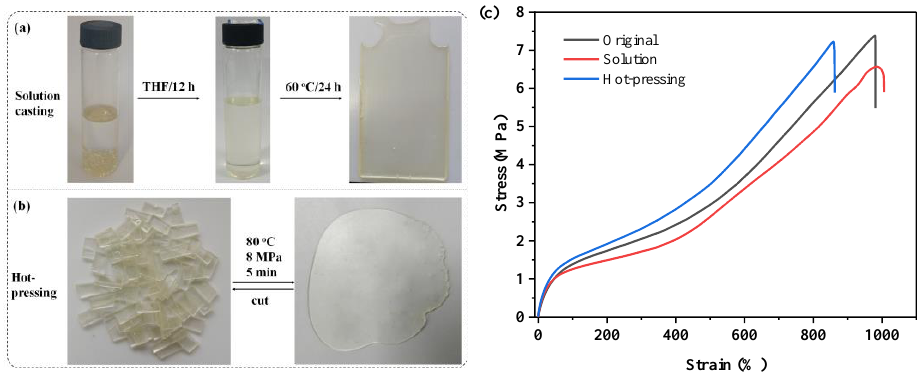
Figure 8. Recyclability of ZPU film: ( a ) Photographs of ZPU soaked in THF without heating; ( b ) Photographs of ZPU reprocessed by hot-pressing; ( c ) Strain – stress curves of the original and recycled ZPU samples.